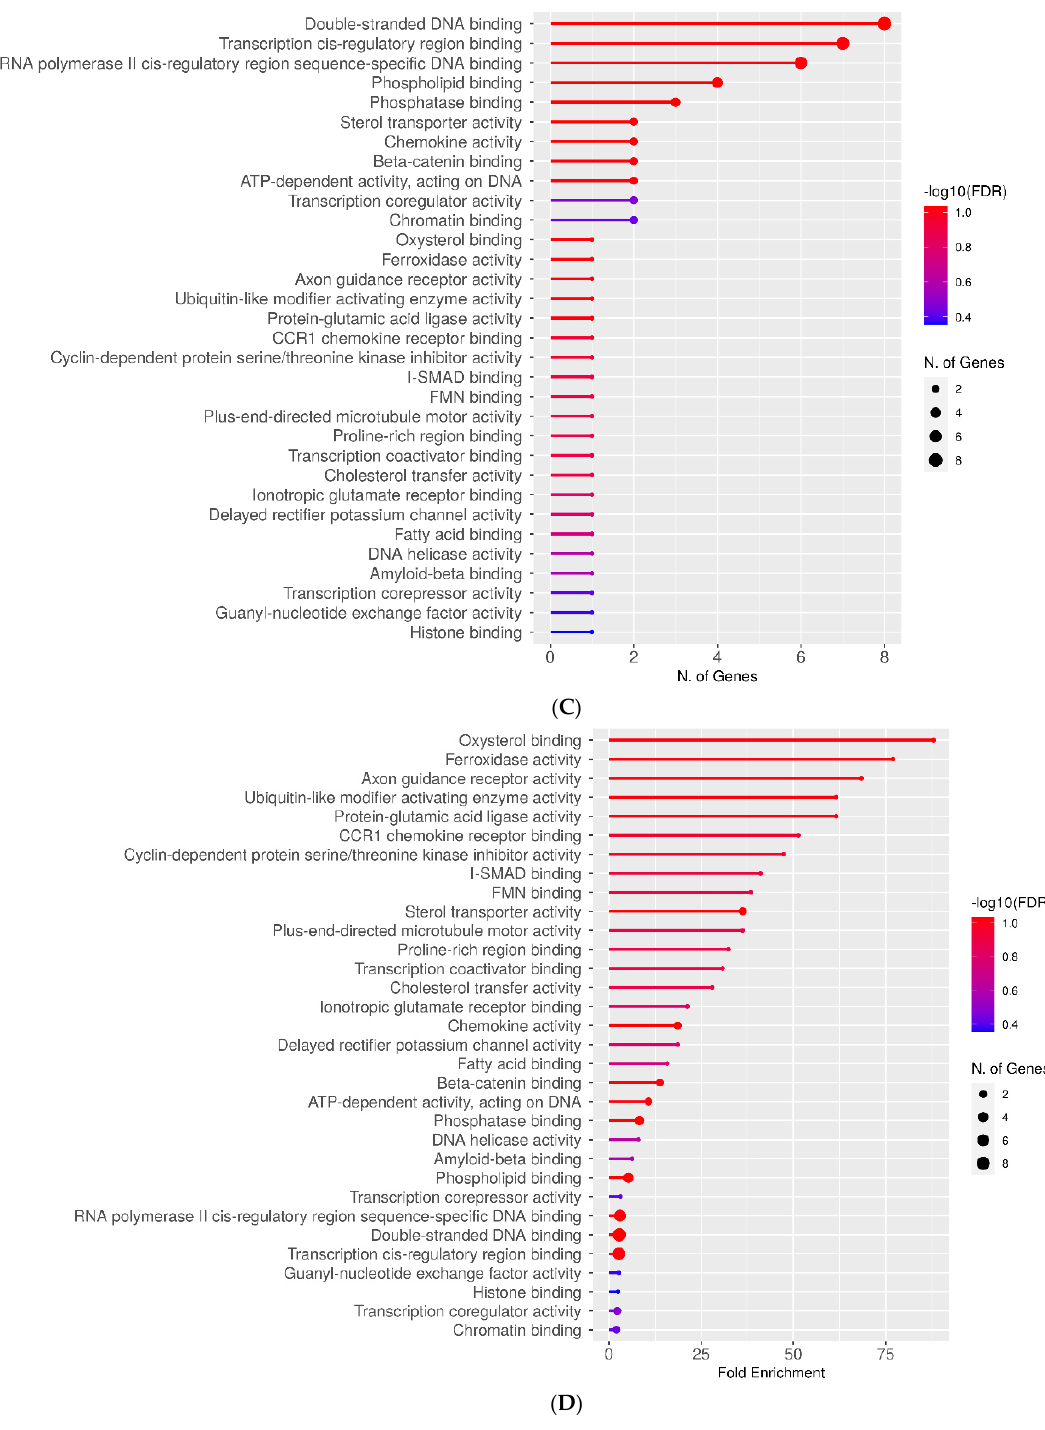
Figure 2. Gene ontology term ‐ based molecular function categorization of genes encoding ( A , B ) AFP 14–20 ‐ like motif ‐ containing proteins and ( C , D ) GIP ‐ 9 ‐ like motif ‐ containing proteins with the use of the ShinyGO v075 suite. Categories are ranked by ( A , C ) number of genes and ( C , D ) fold enrichment. Lolipop chats with an aspect ratio of 1.5 and − log10 (FDR) heat maps for each category are